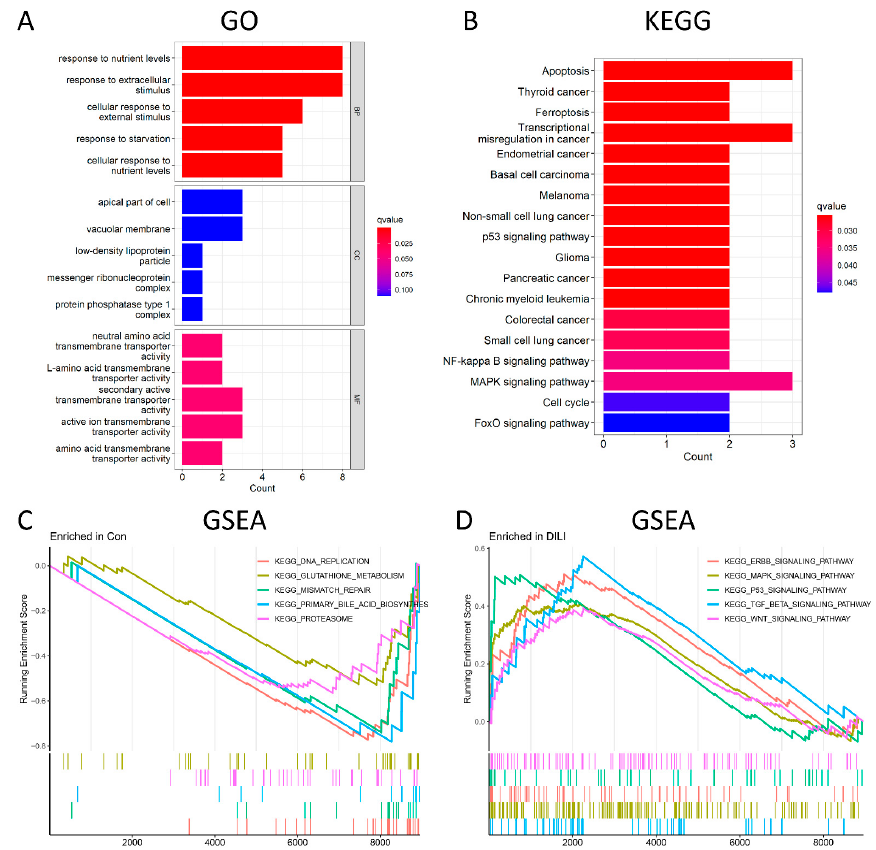
Figure 3. Functional and pathway enrichment analysis. ( A ): The top − 5 BP terms, top − 5 CC terms, and top − 5 MF terms enriched in GO term. ( B ) The 18 significantly enriched KEGG pathways. ( C ) The top − 5 most significantly enriched GSEA-KEGG control terms. ( D ) The top − 5 most significantly enriched GSEA-KEGG DILI terms. BP, biological process; CC, cellular component; MF, molecular function. Count represents the number of genes enriched in the GO or KEGG entry. The Q value is the p value after multiple correction, which is represented by color. The redder it is, the smaller the q value is and the more obvious the enrichment is.